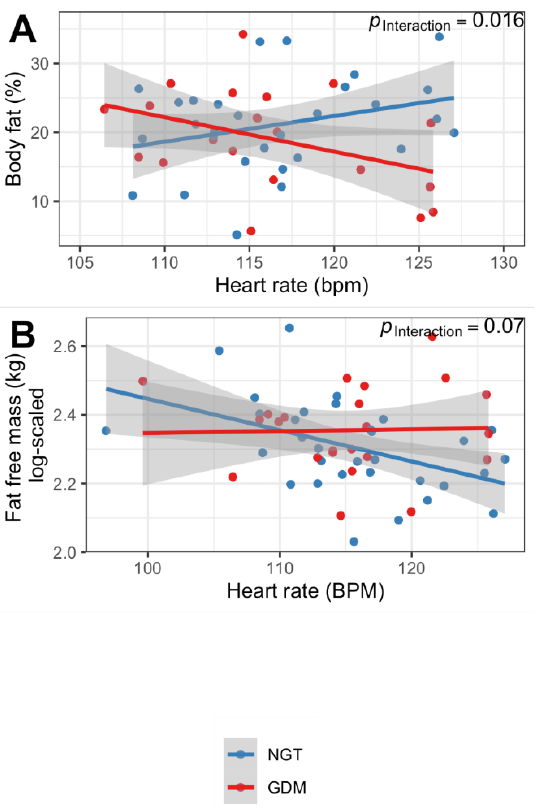
Figure 2. Association of heart rate with percent body fat ( A ) and fat-free mass ( B ) in 2-year-old children. Interaction of GDM status and heart rate.